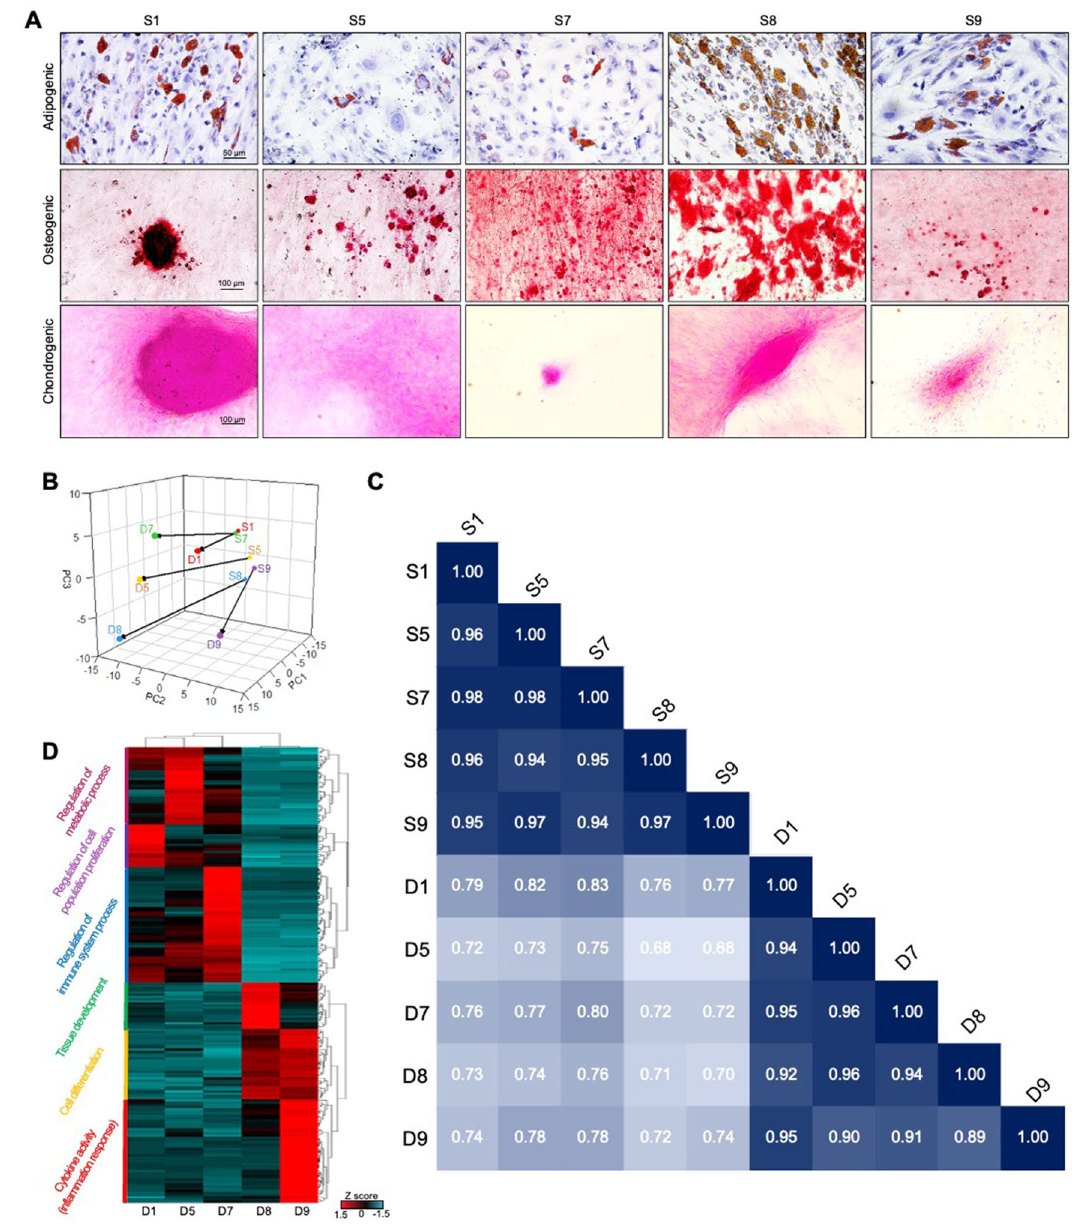
Figure 5. Evaluation of deep learning-based prediction by differentiating hNTSCs. ( A ) Tri-lineage differentiation results using adipogenic, osteogenic, and chondrogenic differentiation conditions. ( B – D ) Ex vivo differentiation results for the development of the bioengineered cornea: Comparison of original and differentiated cells visualized by ( B ) PCA plot and ( C ) Pearson correlation values. ( D ) A heat map presenting the representative functions of the differentiated